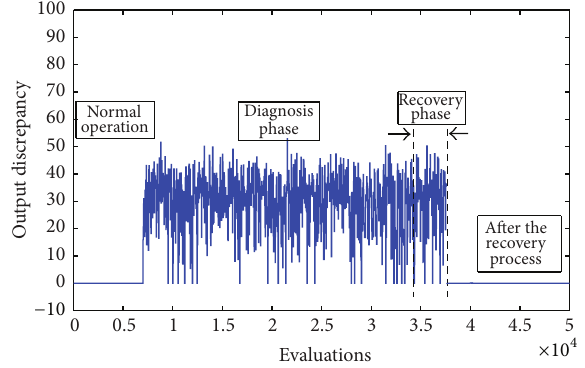
Figure 12: An operational example of a circuit on a ×10 4 evaluations